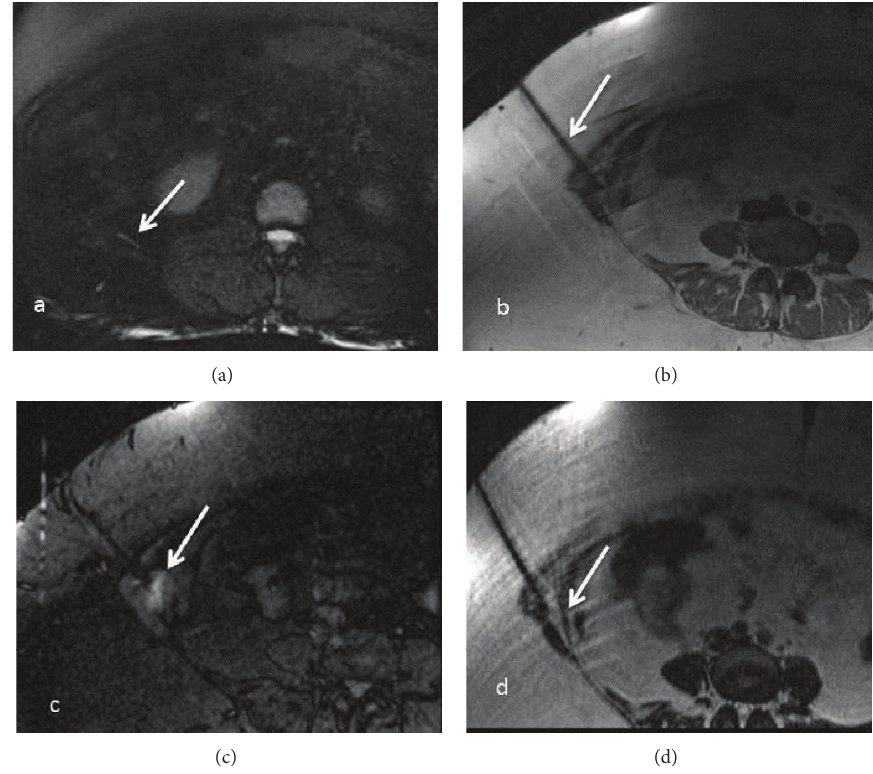
Figure 13: (a)–(d) MRN guided intervention-Axial T2 SPAIR (a), PDW (b), STIR (c), and T2 SPACE (d) images obtained during injection of local anesthetic and steroid combination around the right ilioinguinal nerve (arrow in a), beneath the external oblique aponeurosis. The patient experienced no significant pain relief following the injection in keeping with a negative block.